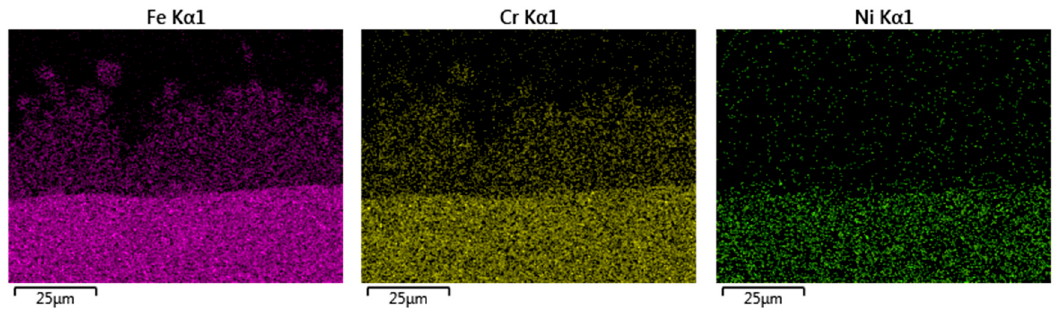
Figure 18. E 18 8 Mn B 2 2 / 680 ± 20 ◦ C / 300 min / AlSi9. Intermetallic compounds at the boundary between the E 18 8 Mn B 2 2 deposit and the solidified aluminum alloy melt ( a ). EDX semi-quantitative microanalyses ( b ).